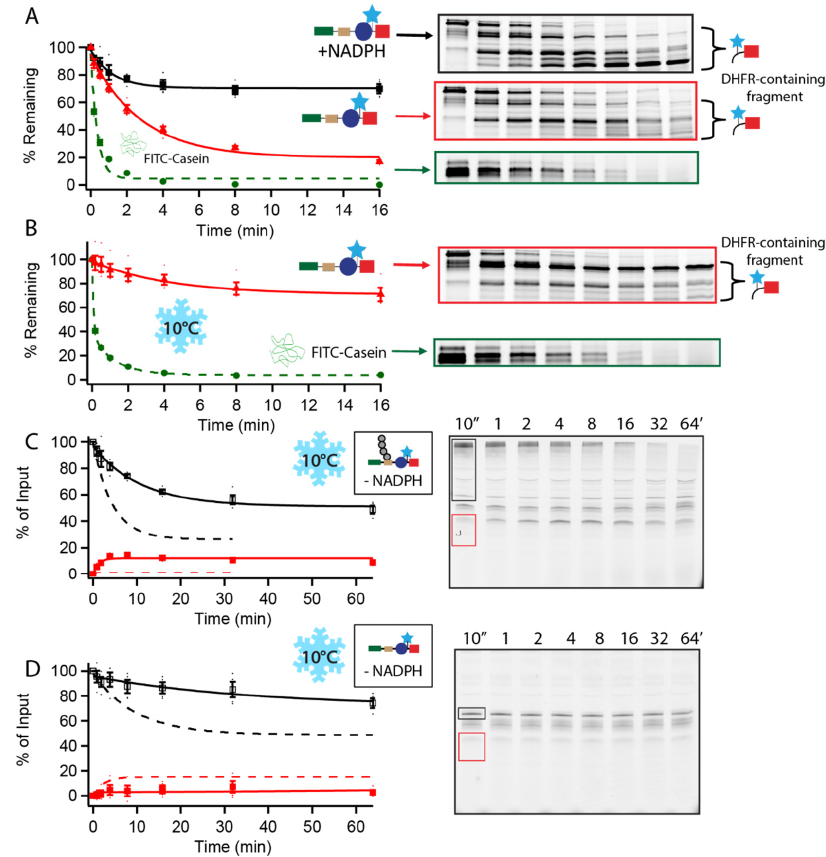
Figure 3. Substrate is folded in a native state and stabilized by NADPH. ( A , B ) Proteolysis of 80 nM Rpn4 1–80 -PPXY-Barnase ∆ KL89G-C-DHFRk ∆ C (black squares, red triangles) and 2.5 µ g/mL FITC-Casein (green circles) by 0.0125 mg/mL Thermolysin at ( A ) 30 ◦ C and ( B ) 10 ◦ C. Example gels show full-length, nonubiquitinated substrate in the presence (outlined in black) and absence (outlined in red) of NADPH, and FITC-casein (outlined in green). Full-length substrate is shown as a percentage of total full-length present before the addition of thermolysin. Dots are the results from individual experiments and error bars represent the SEM of 4 experiments. ( C , D ) Degradation of 20 nM Rpn4 1–80 -PPXY-Barnase ∆ KL89G-C-DHFRk ∆ C by 100 nM WT proteasome at 10 ◦ C. Example gels show full-length substrate, ( A , B ) ubiquitinated or ( C , D ) nonubiquitinated outlined in black, and DHFR fragment outlined in red. Full-length (open squares) and DHFR fragment (closed squares) are shown as a percentage of total full-length present at the beginning of the reaction; full length is quantified as the sum of ubiquitinated and nonubiquitinated substrate so any deubiquitination is not misinterpreted as degradation. Dots are the results from individual experiments and error bars represent the SEM of 3–4 experiments. Dashed lines are the results from identical experiments performed at 30 ◦ C from Figure